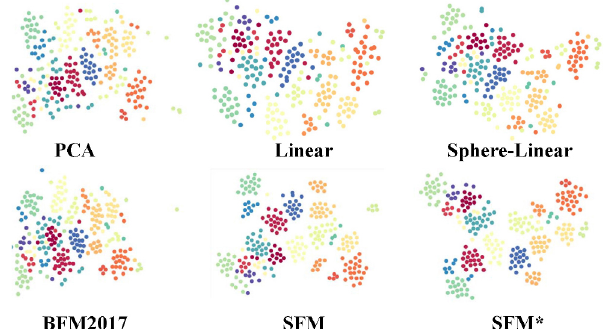
Fig. 5 Latent vector distributions of different methods. We select 20 people on FRGCv2, fitting the shape parameter, and then use t-SNE to reduce the shape parameter to two dimensions and display it on this figure. Different colors represent different people. The SFM* is the SFM finetuned with 2D data.